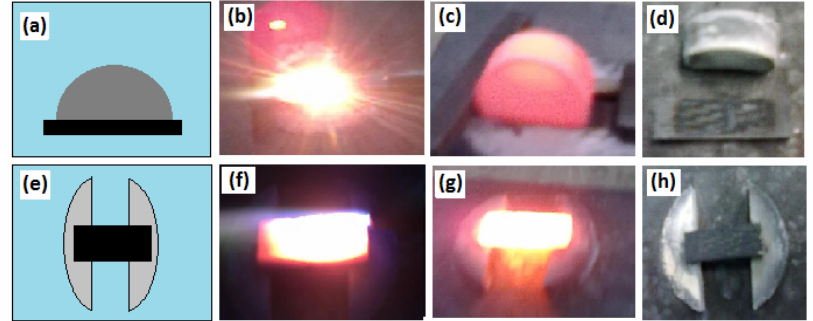
Fig. 10 Arrangement of Cf–SiC composite specimen (black) for exposure to oxy-propane flame of 2300 ℃ : (a) with protection of PLRS 2.0 composite, (b) during exposure to flame, (c) during cooling, and (d) after exposure for total 600 s. (e) Cf–SiC composite without protection, (f) during exposure to flame, (g) immediately after withdrawn of the flame, and (h) after exposure for total 600